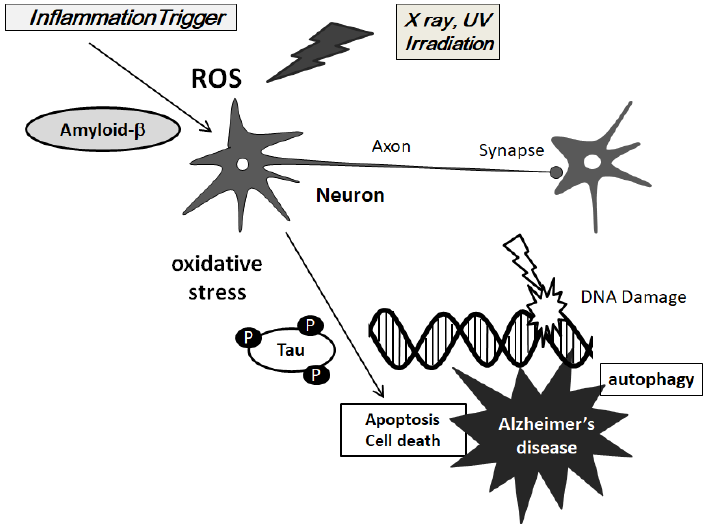
Figure 1. Hypothetical schematic image of the pathogenesis pathway for Alzheimer’s disease is shown. Inflammation trigger, amyloid-β, X-ray, and UV irradiation all contribute to the ROS formation. The uncontrolled generation of ROS and oxidative stress mediated by inflammation and/or amyloid-β might contribute to neuron apoptosis via the hyper-phosphorylation of tau protein. Note that some critical pathways such as NADPH oxidase activation have been omitted for clarity.